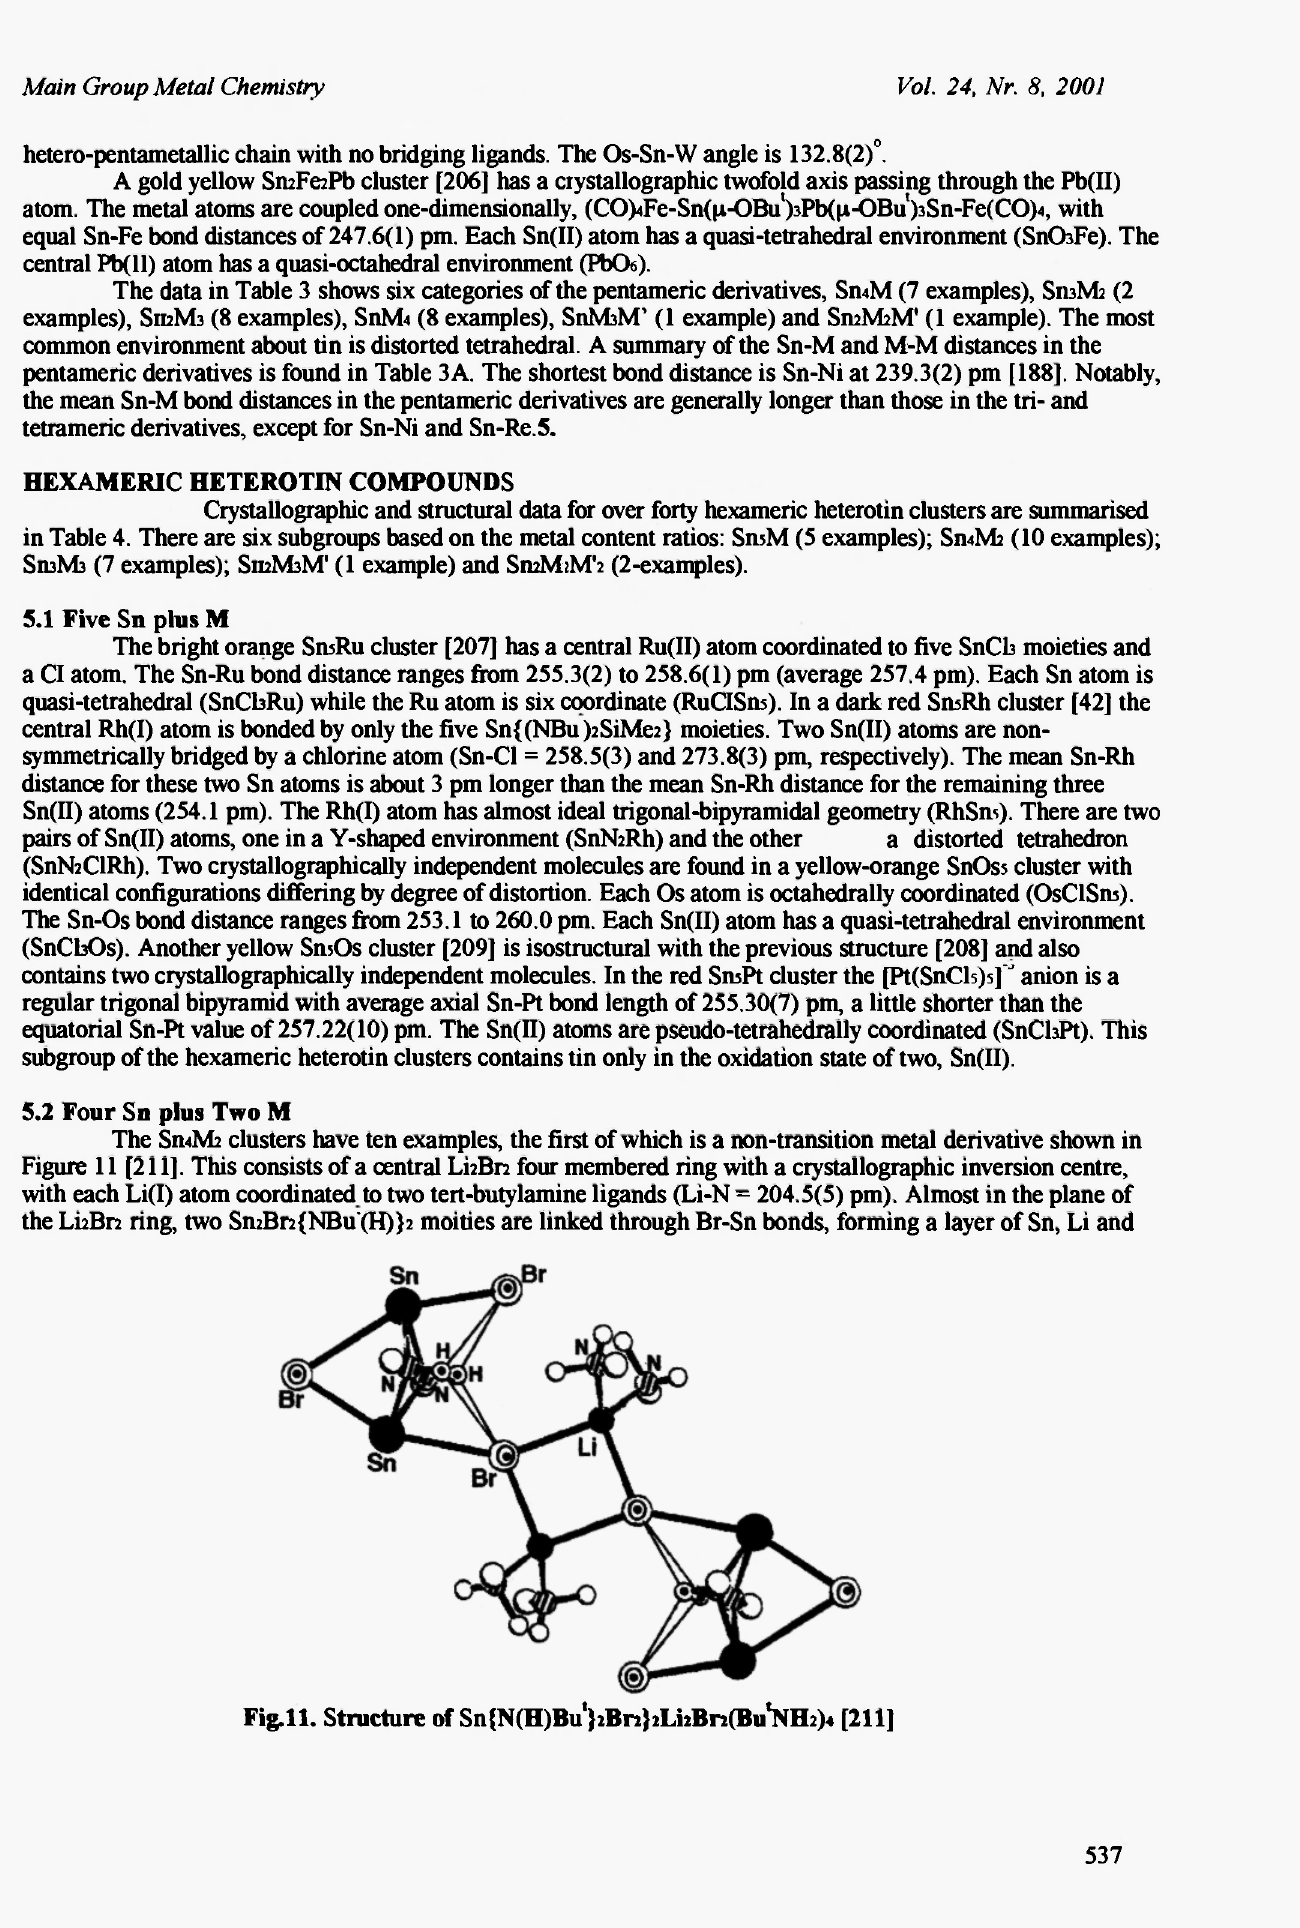
Fig.ll. Structure of Sn{N(H)Bu'}iBn}2LiiBn(Bu , NH2)4